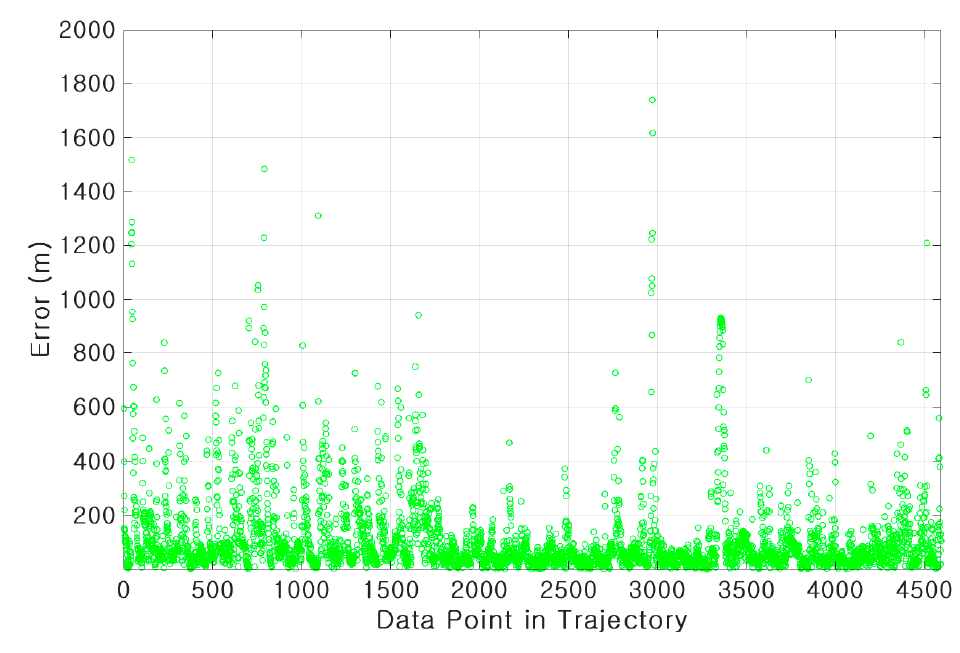
( l ) Error scatter plot for group B using GRU. Figure 8. Results of trajectory prediction. Figure 8. Results of trajectory